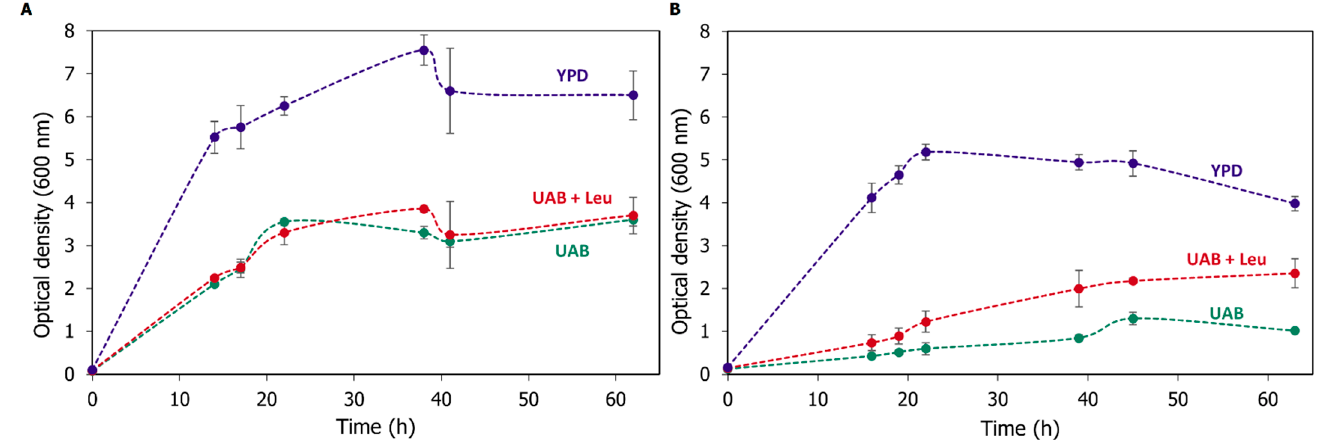
Figure 4. Growth curves of K. phaffii strains cultivated in 500 mL baffled flasks in 50 mL of YPD (blue), UAB (green), and UAB with L-leucine (red), all sourced with 2% dextrose: ( A ) GLp; ( B ) GLpm. Experiments were carried out in biological triplicates. Table 2. The specific growth rate ( μ : h − 1 ) of GLp and GLpm in shake-flasks.